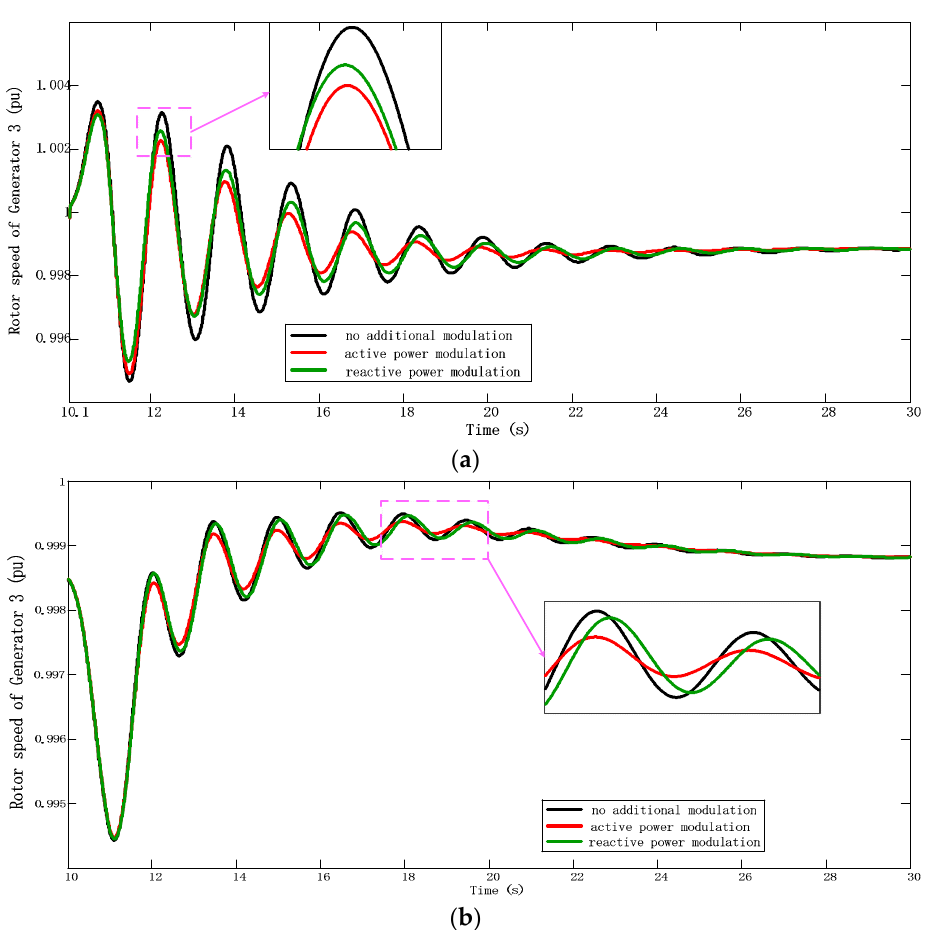
Figure 7. ( a ) Rotor speed of Generator 3 at Case A; ( b ) Rotor speed of Generator 3 at Case B.